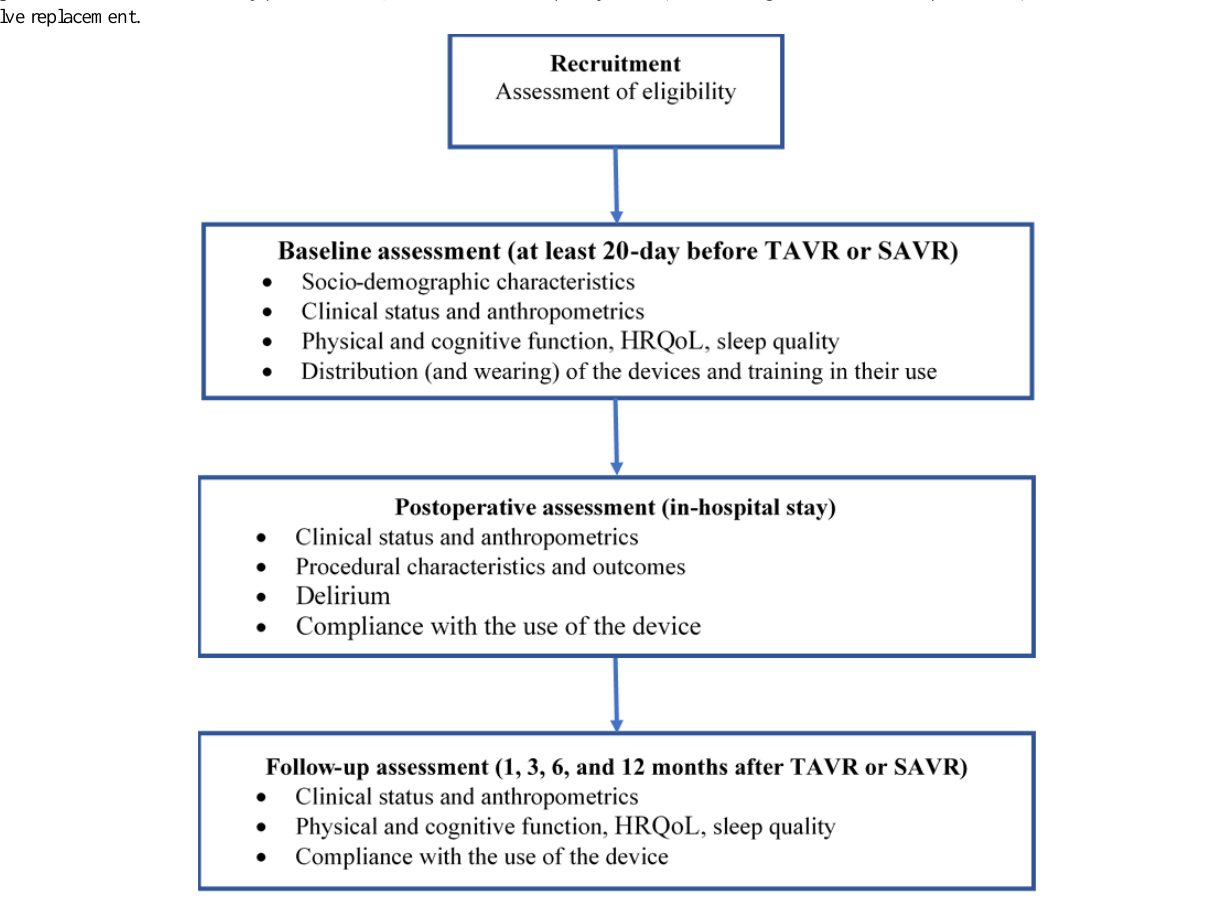
Figure 1. Flowchart of the study protocol. HRQoL: health-related quality of life; SAVR: surgical aortic valve replacement; TAVR: transcatheter aortic valve